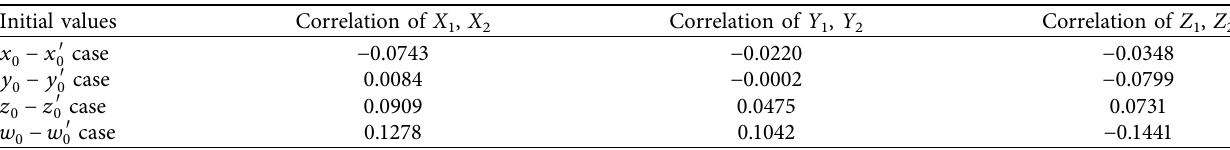
, y ,z , w ] and [ x 0 0 0 0